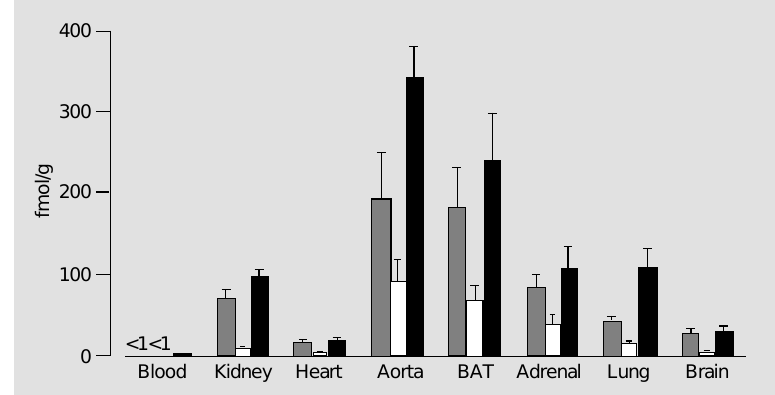
Figure 4 - Levels of BK-(1-7) (gray columns), BK-(1-8) (open columns), and BK-(1-9) (black columns) in blood, kidney, heart, aorta, brown adipose tissue (BAT), adrenal, lung, and brain of normal male Sprague Dawley rats. Data are reported as mean ± SEM. (Reproduced from Ref.